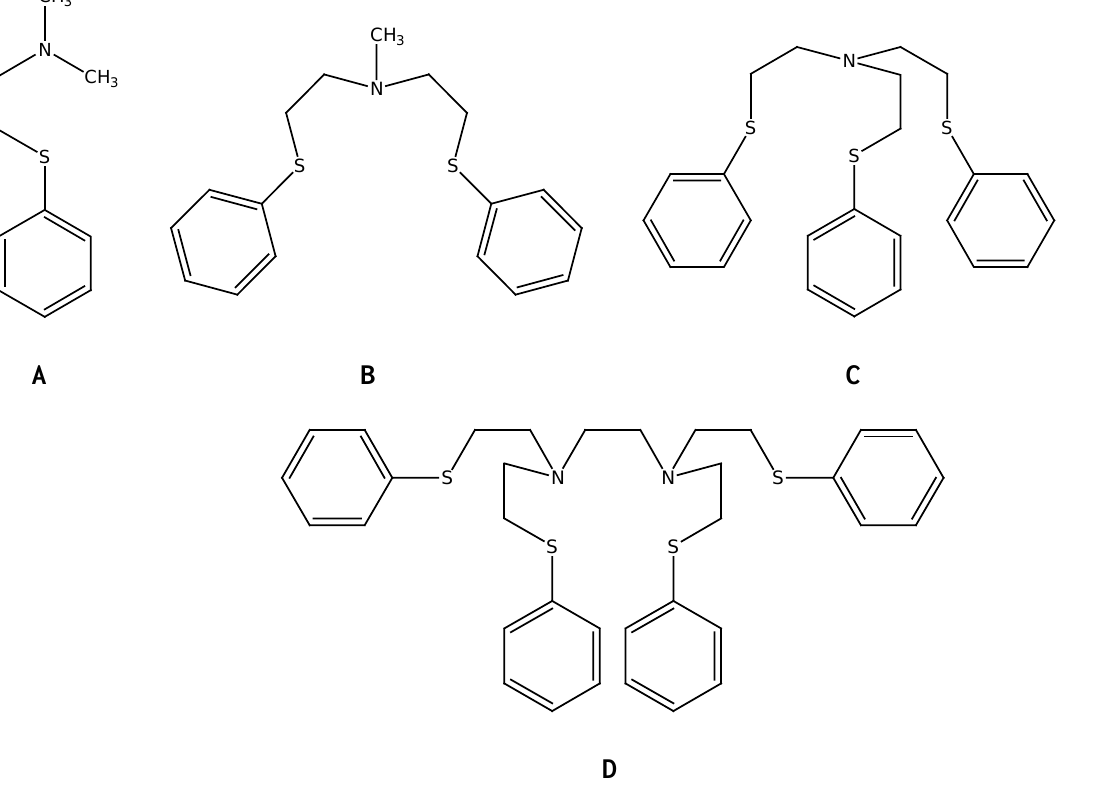
Figure 42. Nitrogen- and sulfur-containing